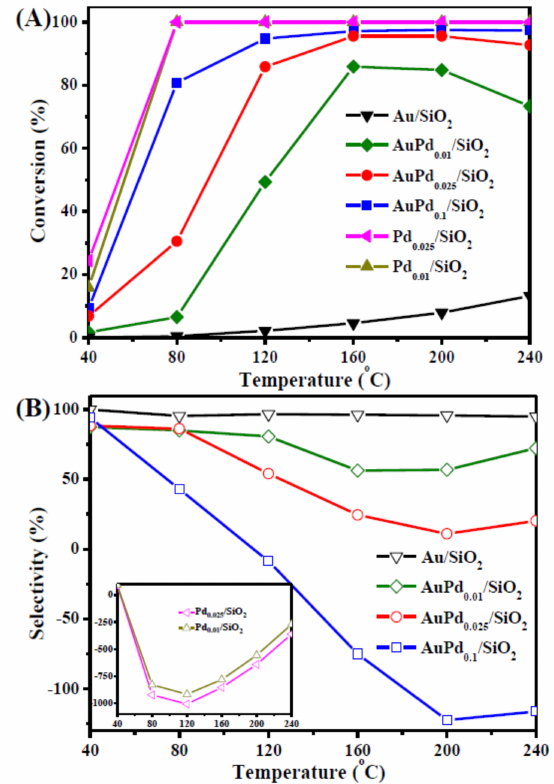
Figure 19. Conversion (A) and (B) selectivity as functions of temperature for acetylene semi-hydrogenation over Au/SiO 2 , AuPd 0.01 /SiO 2 , AuPd 0.025 /SiO 2 and AuPd 0.1 /SiO 2 catalysts (reproduced with permission from [278]. Copyright 2014, the Royal Society of